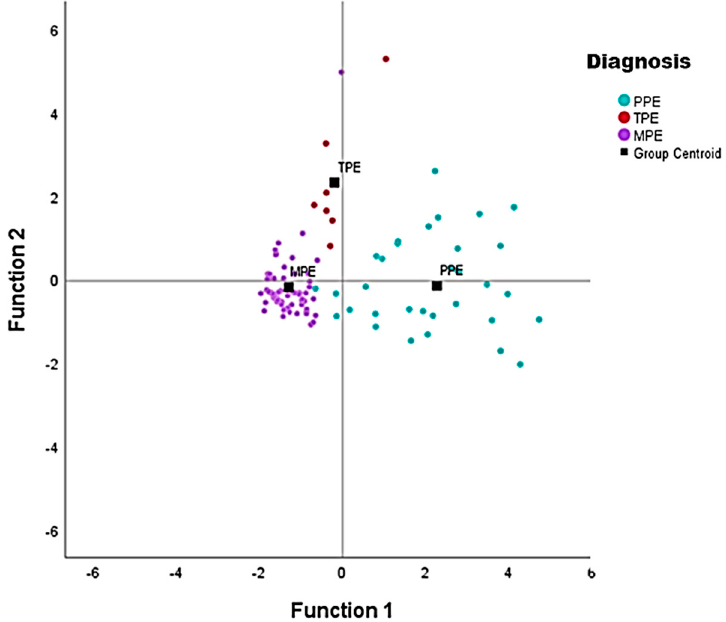
Figure 5. Group centroid diagram of mean values of ADA and CRP for PPE, MPE and TPE. ADA: adenosine deaminase, CRP: C–reactive protein, PPE: parapneumonic pleural effusions, MPE: ma- lignant pleural effusions, TPE: tuberculous pleural